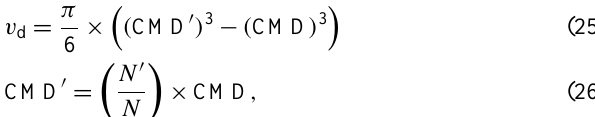
Table 4. The uncertainty budget in the measurement of PSL-60nm reference particles. Source of Probability Standard Sensitivity Degree of uncertainty (nm) distribution uncertainty (nm) coefficient freedom Mode peak (Repeatability) Normal-TypeA 0.380 0.420 CMD correction Normal-TypeA 0.199 Diffusion correction Rectangular-TypeB Charge correction Impactor flow Sheath flow Bypass flow